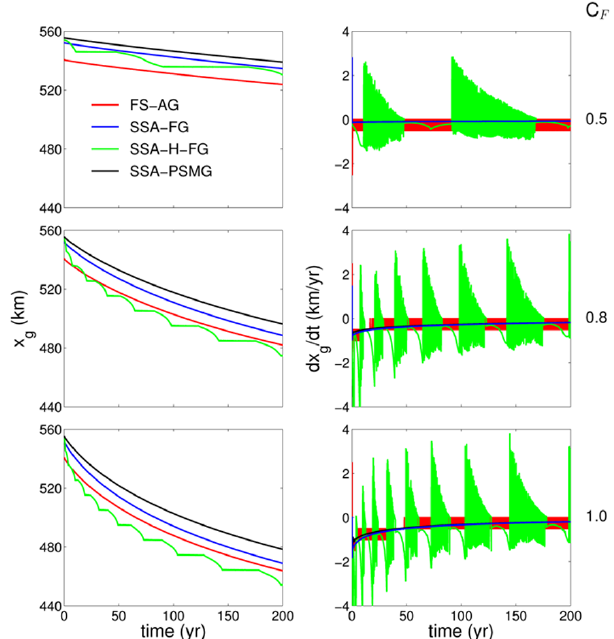
Fig. 2. Grounding line position x g (left) and migration rate d x g / d t (right) as a function of time for the four models and for the three buttressing values ( C F = 0 . 5 on the first line, C F = 0 . 8 on the sec- ond line and C F = 1 on the third